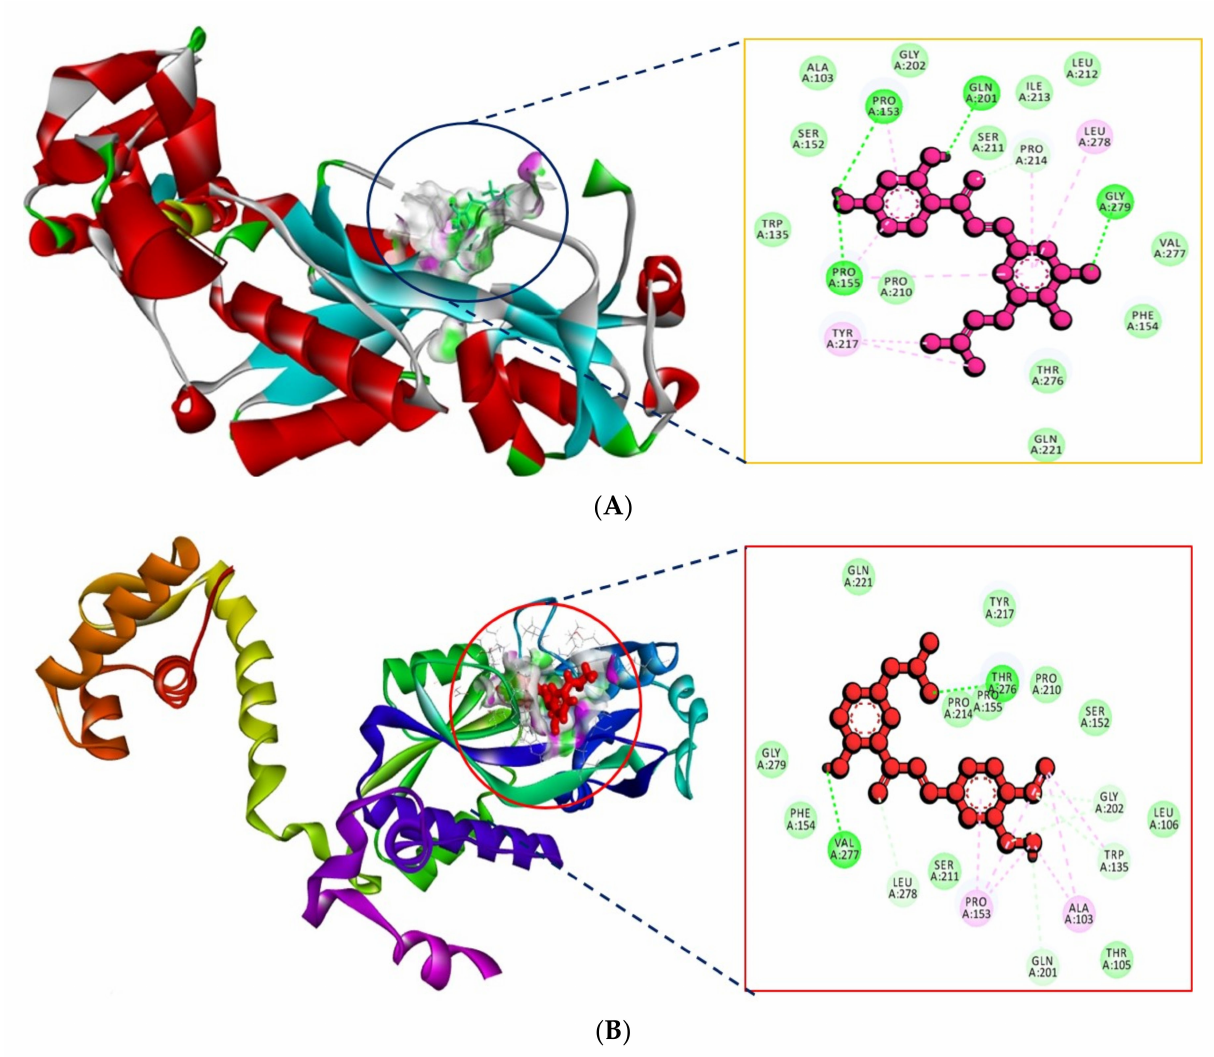
Figure 2. ( A ) Interaction of PhcA with ZINC000014762512. ( B ) Interaction of PhcA with